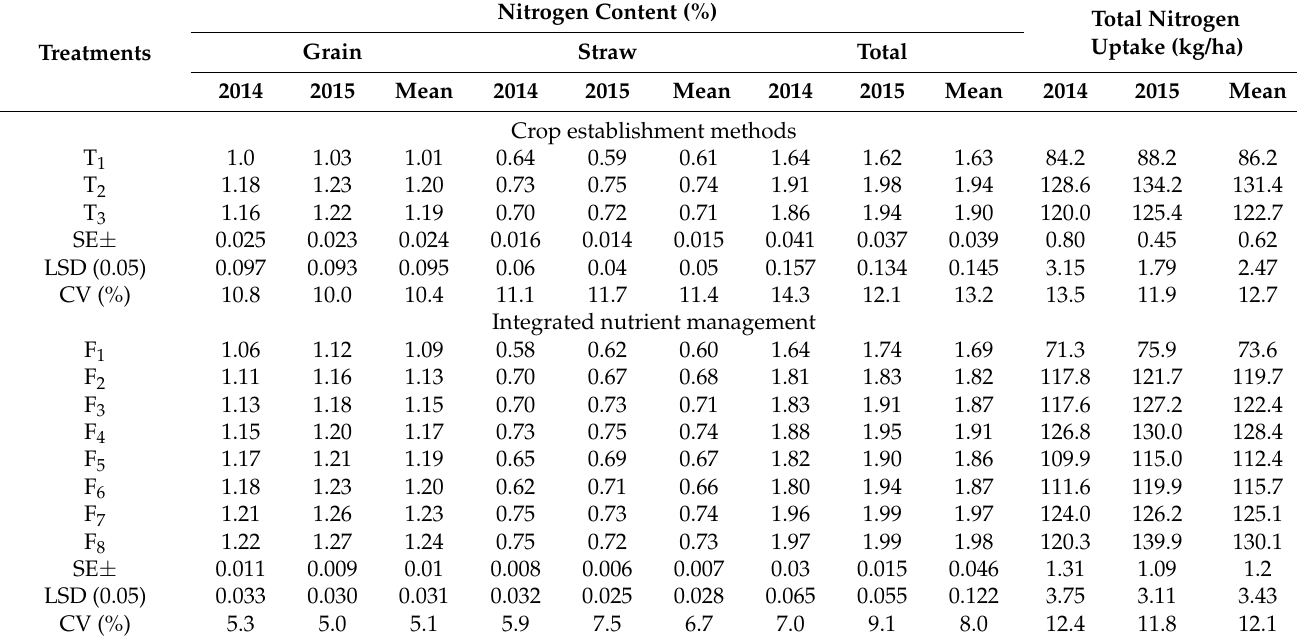
Table 1. Crop establishment methods and integrated nutrient management influence the nitrogen contents and nitrogen uptake by